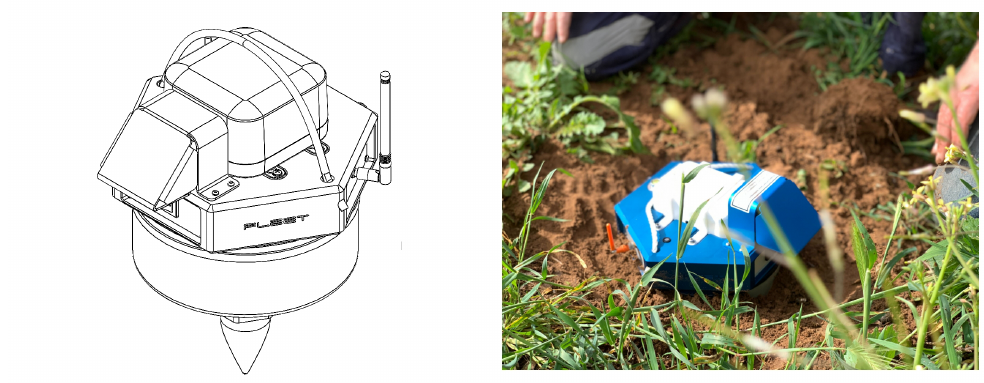
Figure 1. Schematic of the Geode design ( left ) along with a picture of an installed Geode ( right